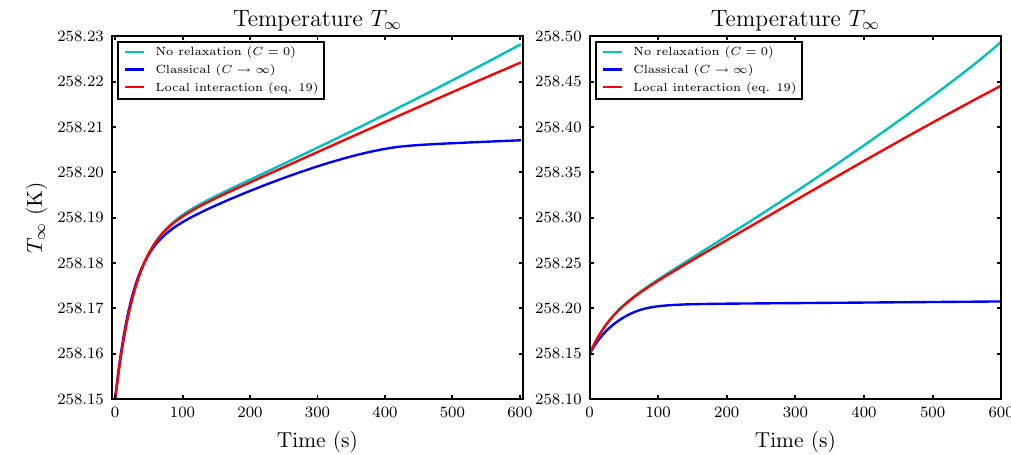
Figure 7. Temporal evolution of the air parcel temperature T ∞ with w = 0ms − 1 and N d = 500 per influence sphere of the ice crystals